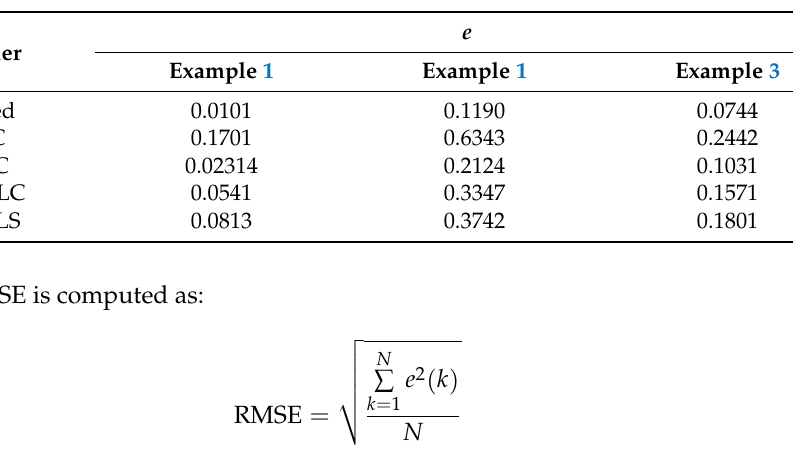
Table 2. Example 4: Comparison of